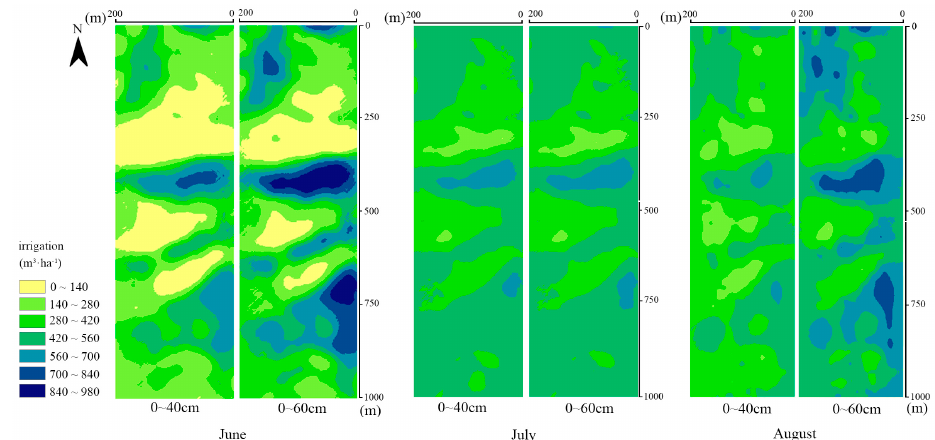
Figure 2. Distribution of irrigation in June, July and August.